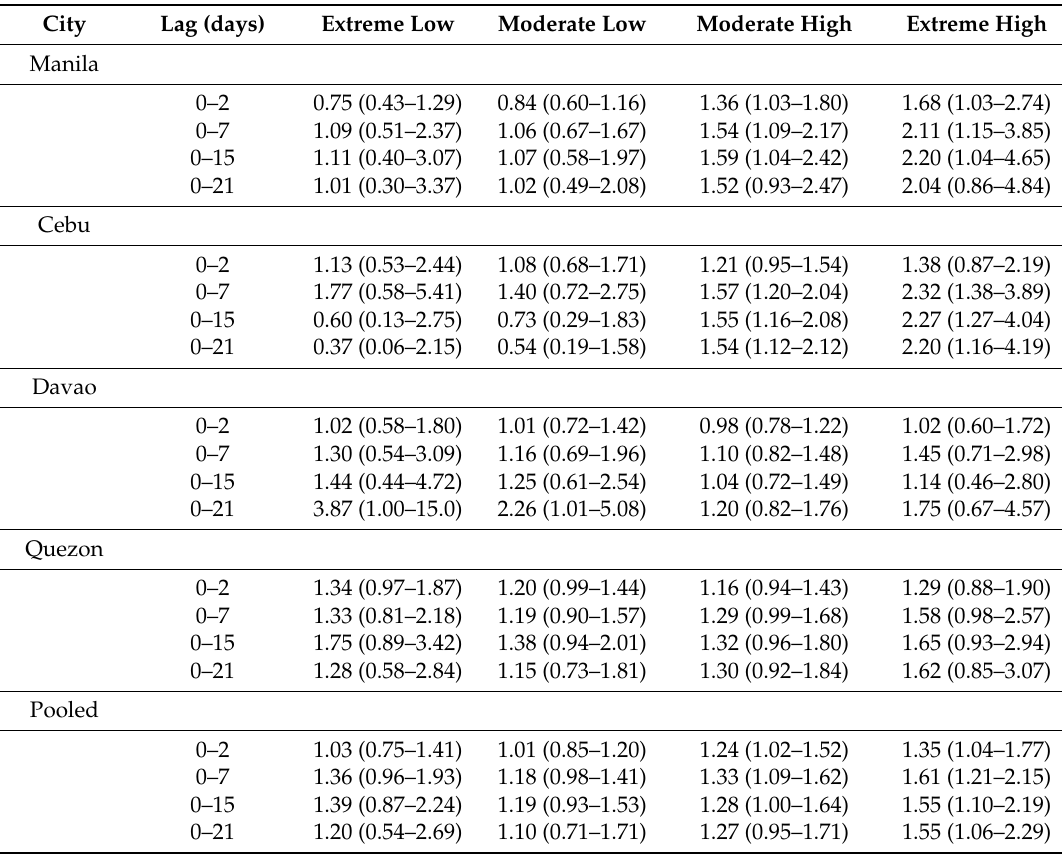
Table 2. Cumulative RRs of cold and hot temperature effects on diabetes mortality along the various lag